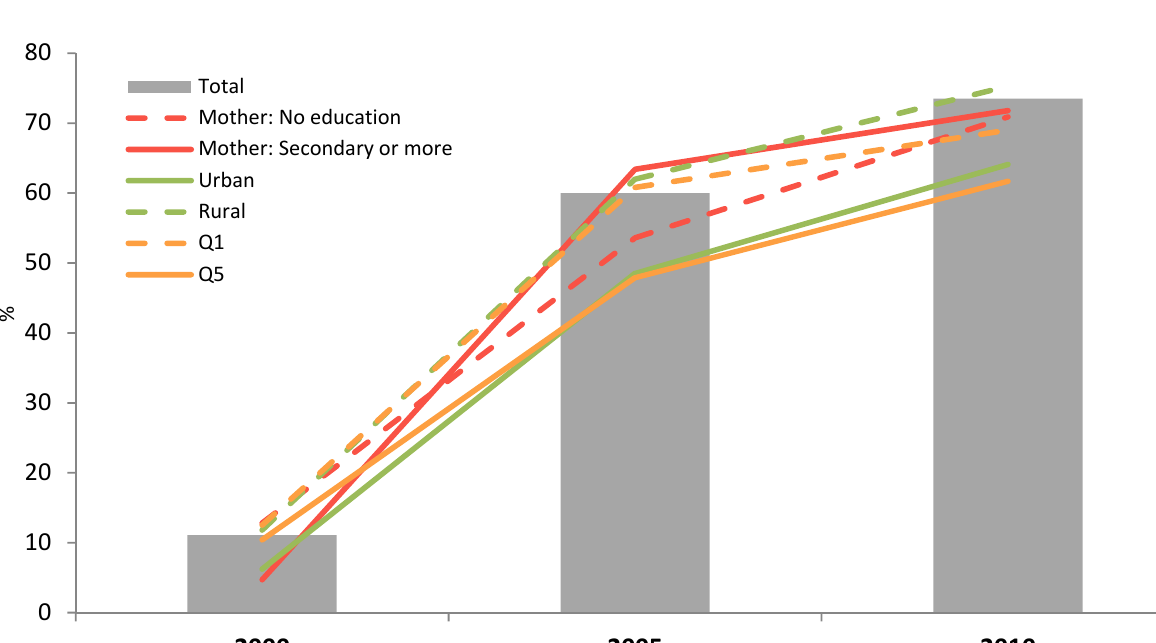
Figure 1. Exclusive breastfeeding (0–5.9 months) by year and according to the mother’s education, household wealth (richest = Q5; poorest = Q1) or living area ( n = 801, 741 and 704 in 2000, 2005 and 2010